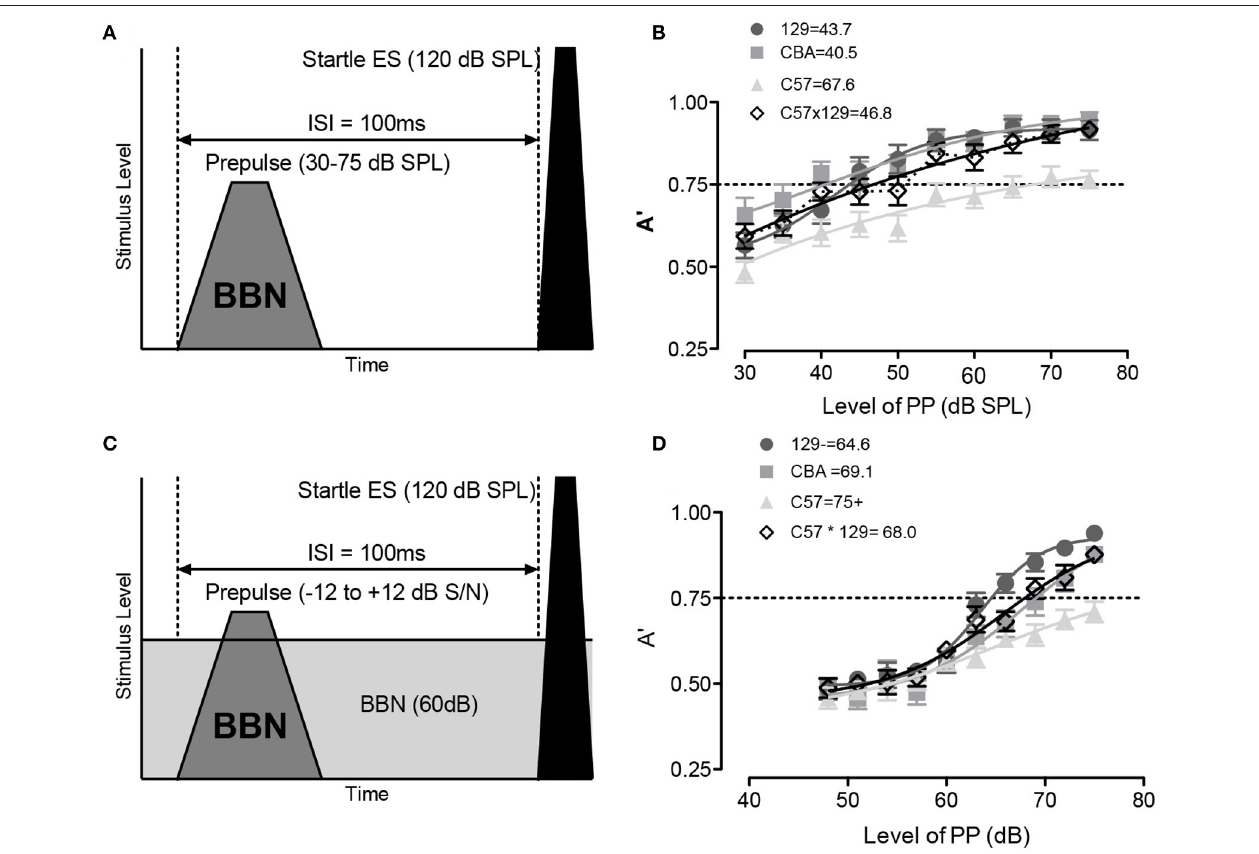
FIGURE 3 | When brief prepulses are detected in quiet and masking noise, they can be used to inhibit the ASR [i.e., prepulse inhibition (PPI)]. PPI can be used then to assess the mouse’s ability to detect prepulse signals presented in quiet or embedded in masking noise. (A) Schematic of prepulse and acoustic startle stimulus. The prepulse was a broad band noise 2–100kHz (BBN), the acoustic startle stimulus was always a BBN delivered at 120 dB. (B) Detection of the broadband (BBN) prepulse was robust in all strains, and increased with level, with A ′ = 0.5 equal to no difference between no prepulse and prepulse (i.e., not detectable), and 50% PPI threshold defined as sound level with A ′ = 0.75, and the numbers next to strain labels indicate the prepulse level (dB SPL) at which this is reached. C57 mice were unusual in having a low asymptotic A ′ to PPI compared to the other strains. (C) Schematic of prepulse and startle stimulus in background masking noise